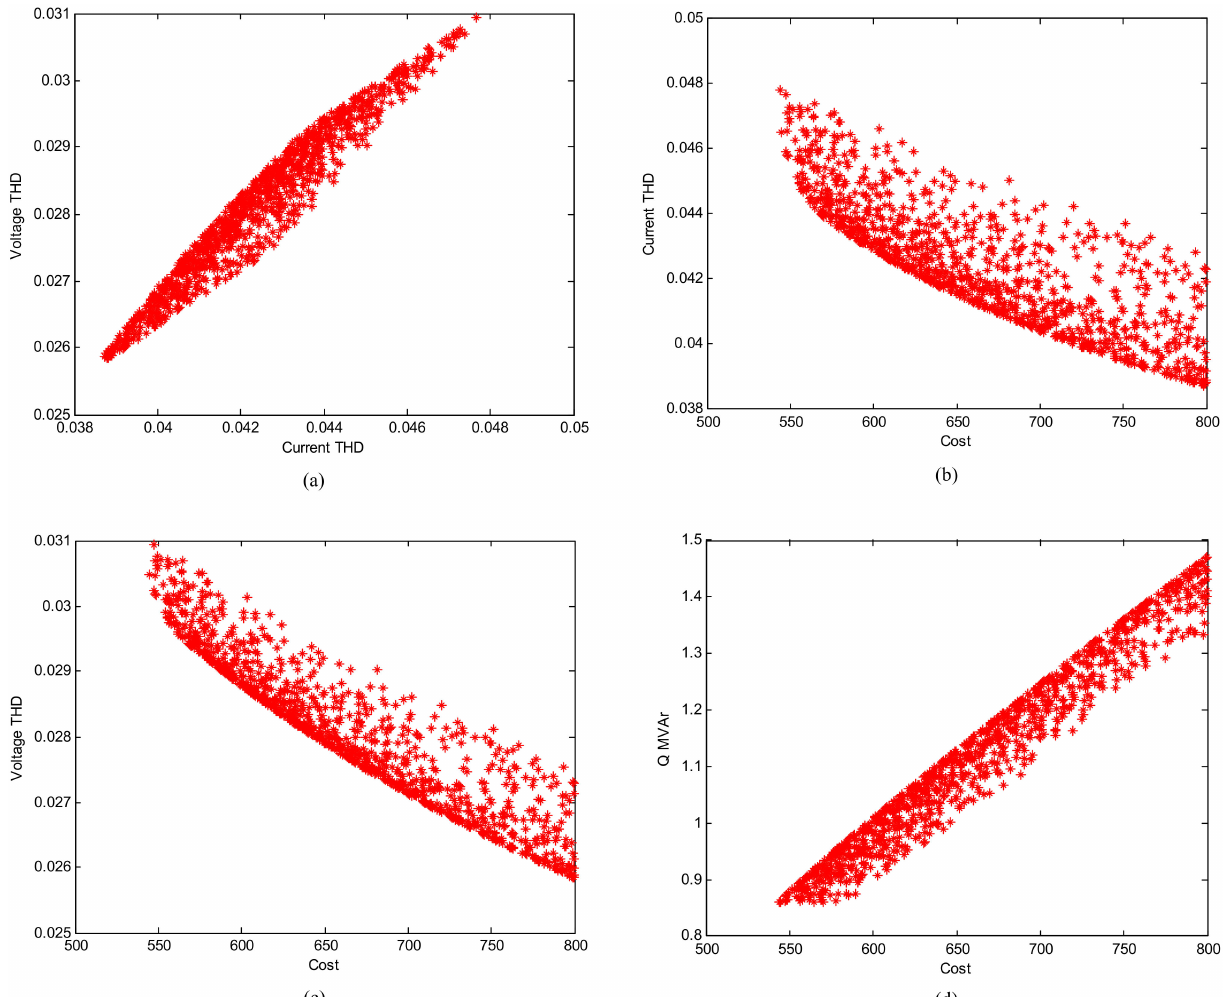
Figure 9. Pareto front set obtained by the proposed TLBO-based method: ( a ) voltage THD vs. current THD; ( b ) current THD vs. cost; ( c ) voltage THD vs. cost; ( d ) reactive power compensation vs. cost.